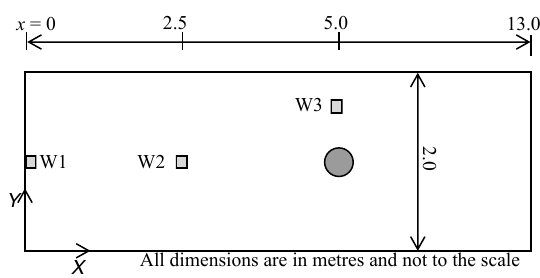
Figure 13. Numerical wave tank setup for simulating the experiments performed at SINTEF Ocean [40] (top-view).